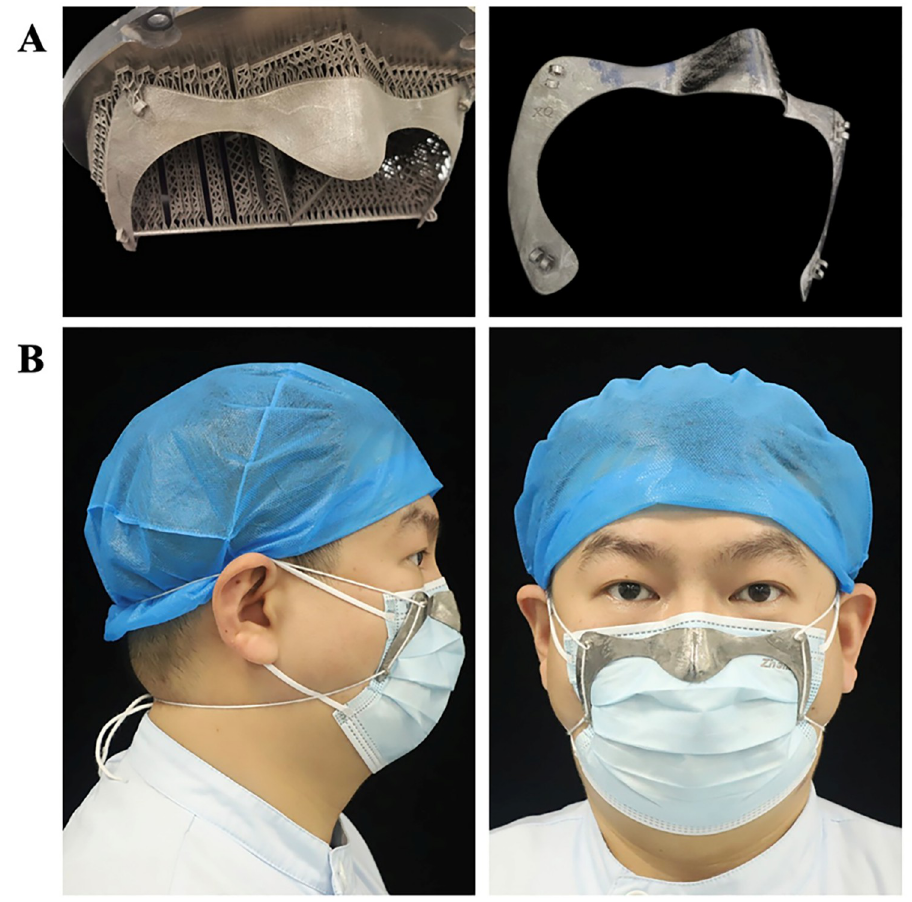
Fig 3. Surgical mask retainer. Panel A shows fabrication of the retainer by using 3D printing technology before and after support was removed. Panel B shows participant wearing surgical mask supplemented by the